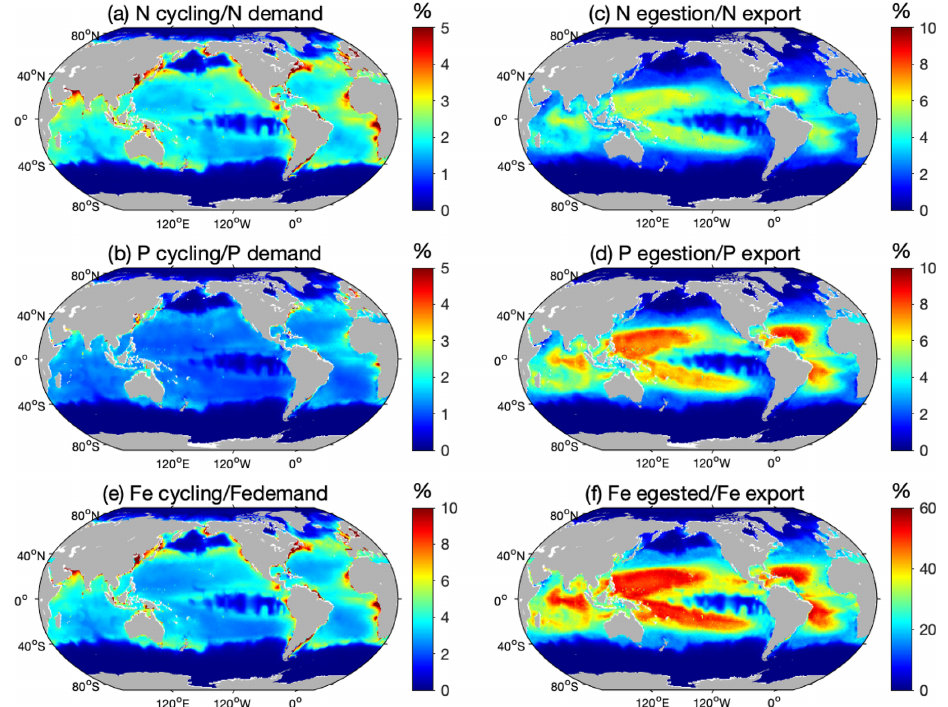
Figure 6. Total nutrient cycling and egestion relative to export. Ratio (%) between the amount of nutrients cycled by the modeled pristine global CTF 100kg biomass and estimated primary producers’ demand for (a) N and (b) P, ratios of the modeled amount of nutrients egested by 10g the pristine CTF 100kg biomass and export at the base of the euphotic zone of (c) N and (d) P, and high-end estimate of the ratio (%) between 10g the modeled amount of (e) Fe cycled by the modeled pristine global CTF 100kg biomass and estimated primary producers’ Fe demand, and 10g (f) Fe egested by the pristine CTF 100kg biomass and Fe export at the base of the euphotic zone. The high-end estimates are obtained using 10g Fe cycling computed from the weighted spatial variation between the low and high Fe:C values of zooplankton and the weighted spatial variation between the averaged Fe:C ratios of phytoplankton in Fe-poor and Fe-rich